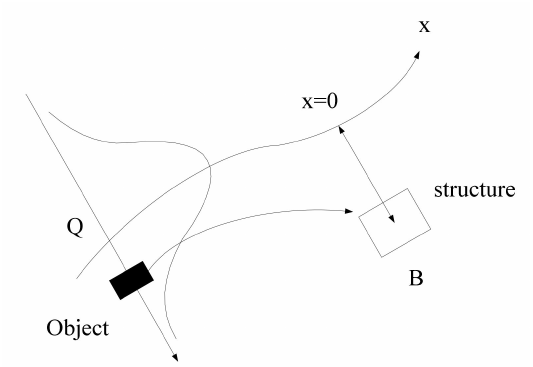
Figure 1. Kunz’s Mathematical collision model [26].